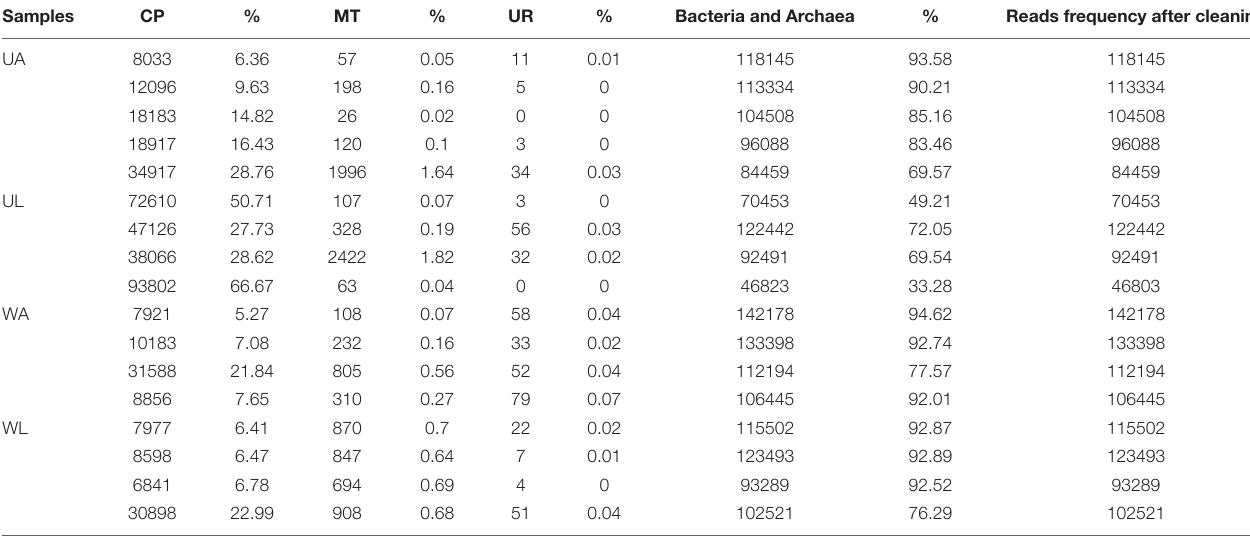
TABLE 1 | Overview of contaminations in the reads after taxonomic assignment. Samples CP % MT % UR % Bacteria and Archaea % Reads frequency after